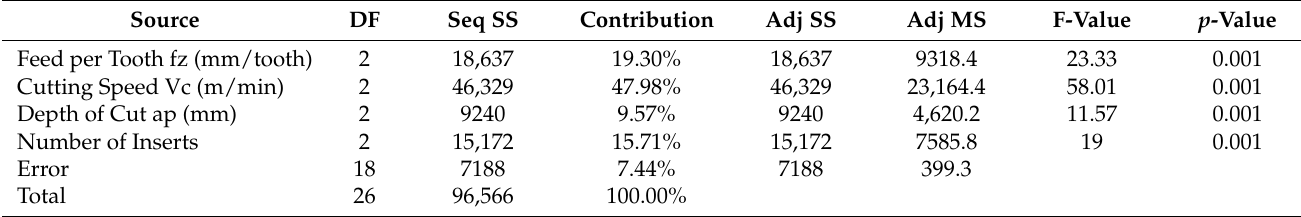
Table 8. ANOVA results for burr width on down-milling side.